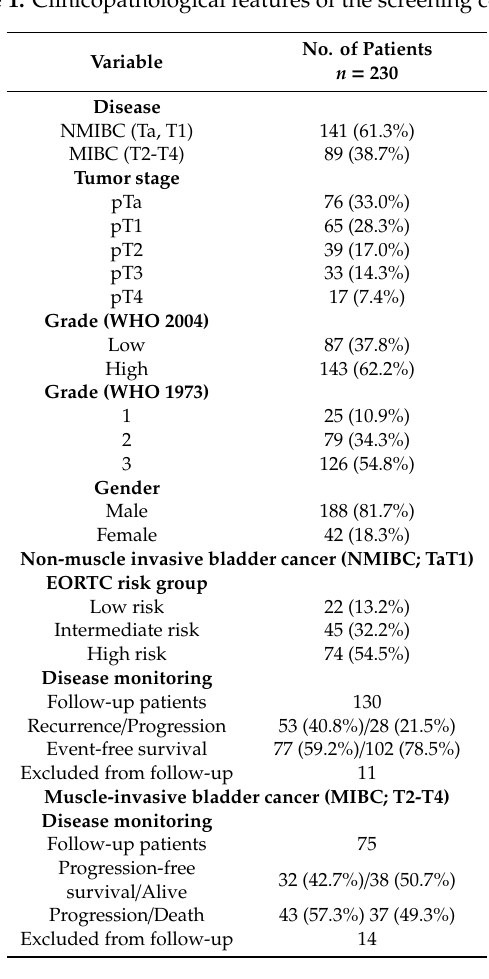
Table 1. Clinicopathological features of the screening